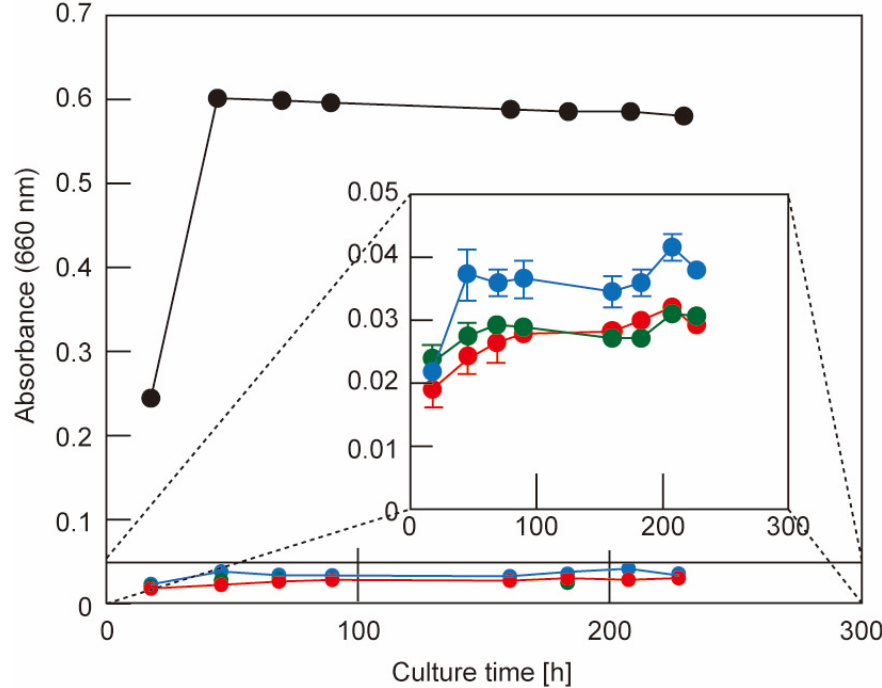
Figure 1. Change of turbidity (absorbance at 660 nm) of the medium caused by R. gra leaked from alginate hydrogel beads during the nitrate assimilation reaction: R. gra suspension (1 mL) or immobilized yeast suspension (10 mL) was added to 100 mL of the water medium containing 10 mg/L nitrate nitrogen. Sodium alginate concentration in the preparation of alginate beads with R. gra , red circle, 1.0%, green circle, 1.5%, blue circle, 2.0%, black circle free R. gra